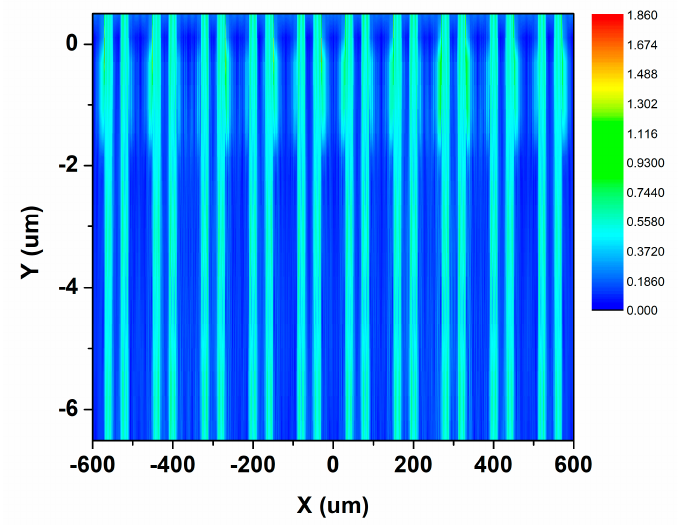
Figure 2. Cross-sectional distribution of the light field in the QCD device. The Y-axis coordinate represents the thickness of the device and the substrate, where zero is the surface of the QCD de- vices.